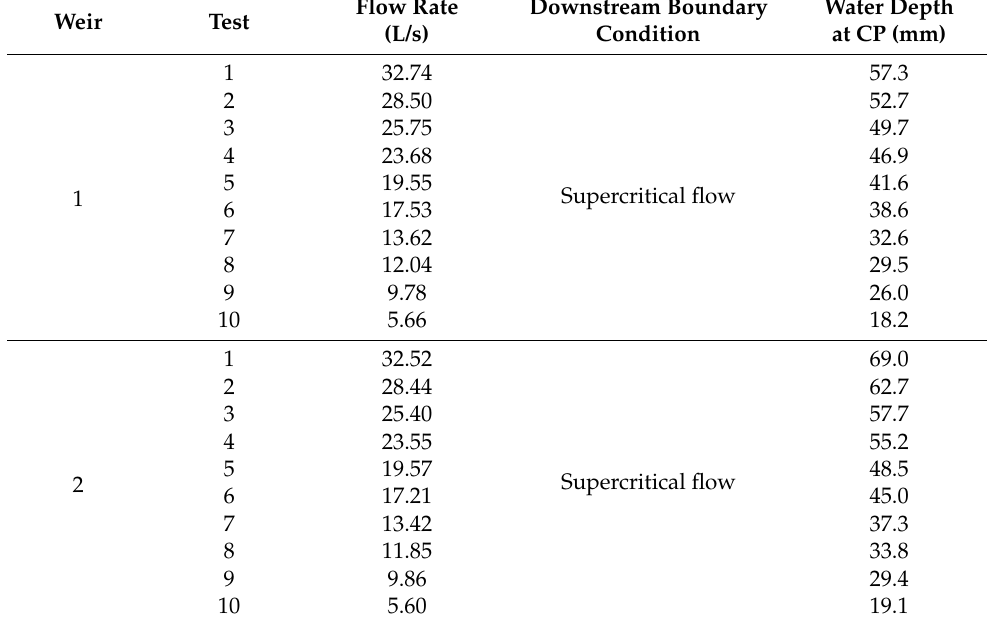
Table A1. Experimental data corresponding to the first experimental